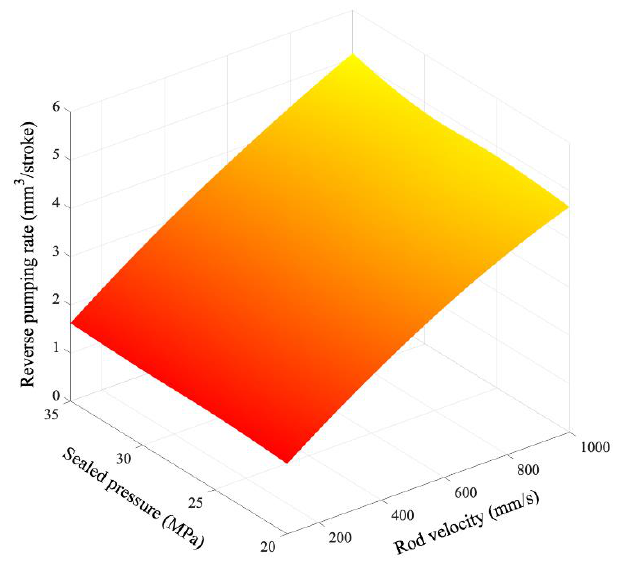
Figure 6. Variation of flow rate with rod velocity.